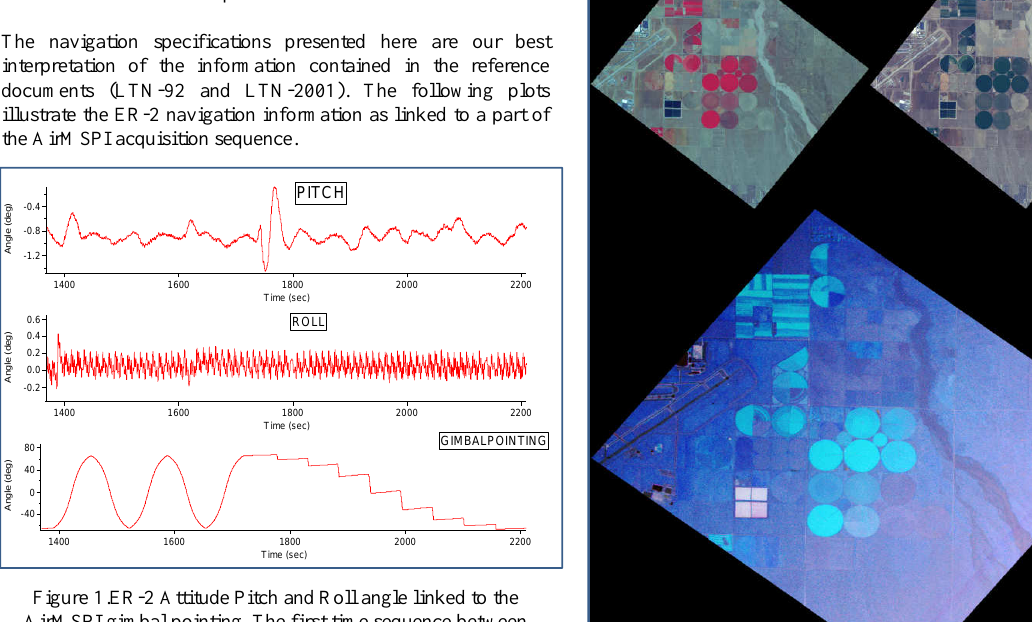
Table 1. Litton (LTN-92/LTN-2001) provided navigation data specifications.